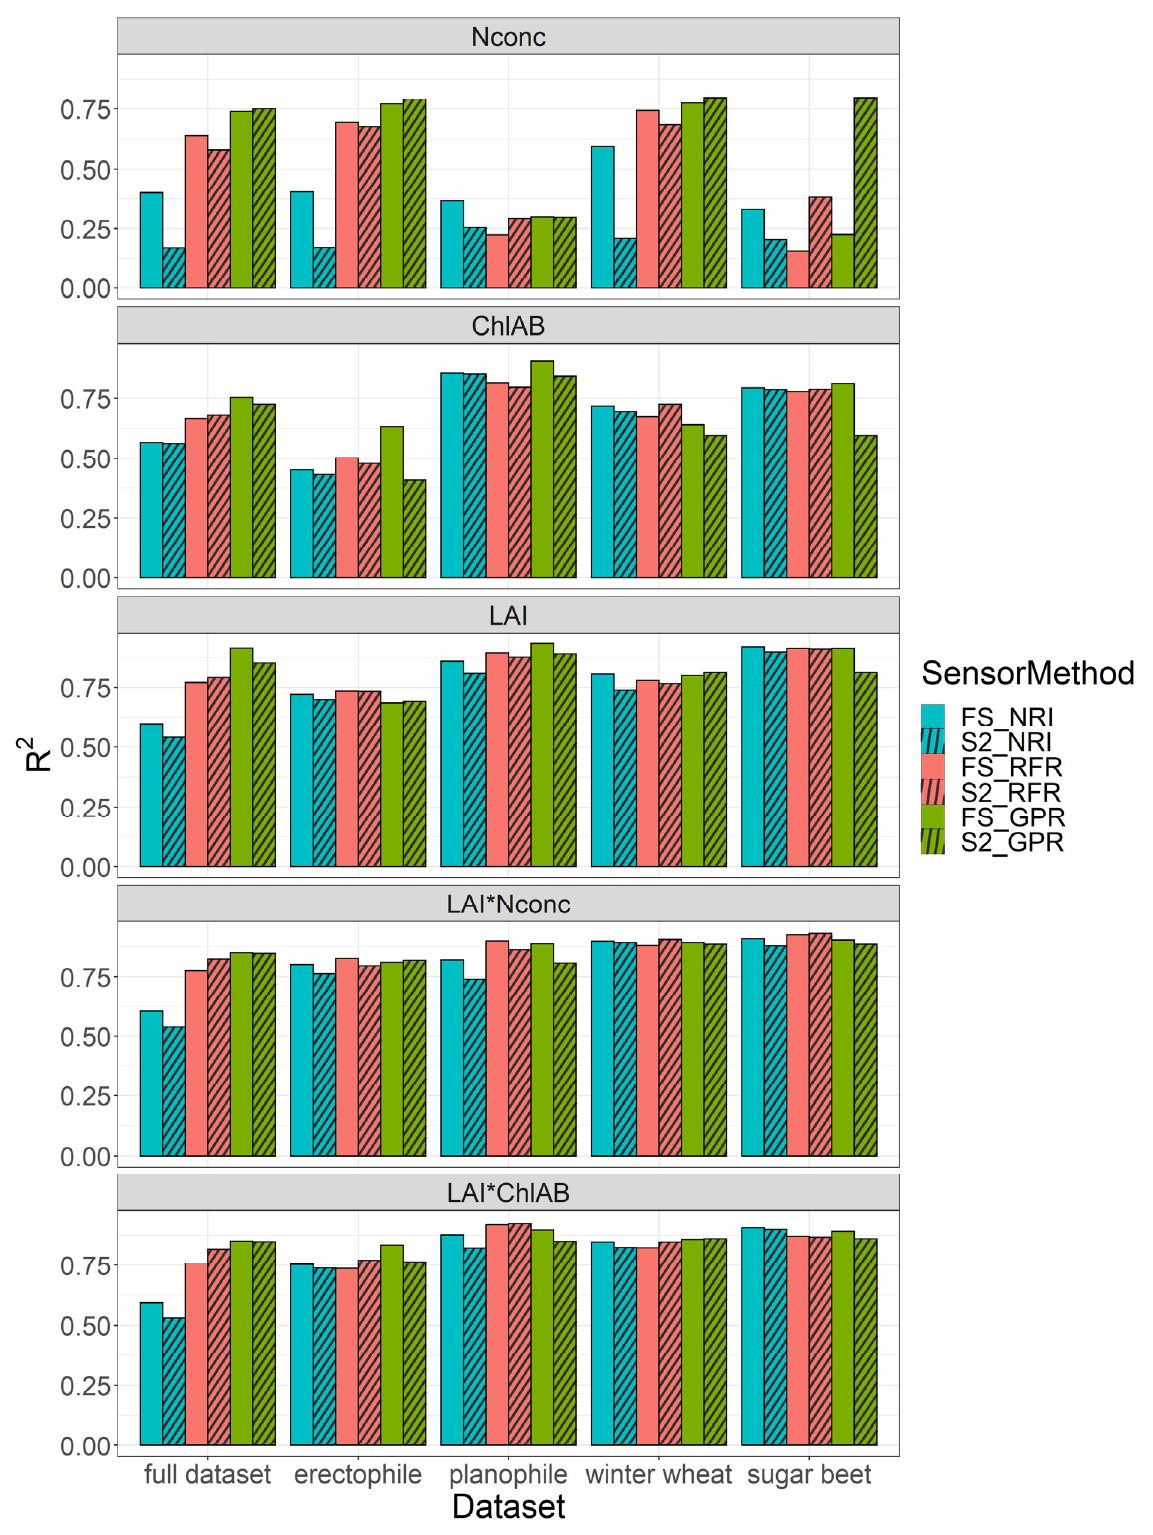
Figure 1. Coefficients of determination (R 2 ) values for the field spectrometer (FS) dataset (empty bars) and the Sentinel-2 (S2) resampled dataset (hatched bars) for the used methods: Normalized Ratio Index (NRI, blue), Random Forest Regression (RFR, red) and Gaussian Processes Regression (GPR, green) as related to the plant traits described in Table 1. For Chl AB , R 2 values for the FS datasets ranged from 0.45 to 0.85 for the NRI ( p < 0.001); from 0.5 to 0.81 for the RFR (RMSE = 0.39 to 0.66) and from 0.63 to 0.91 for the GPR (RMSE